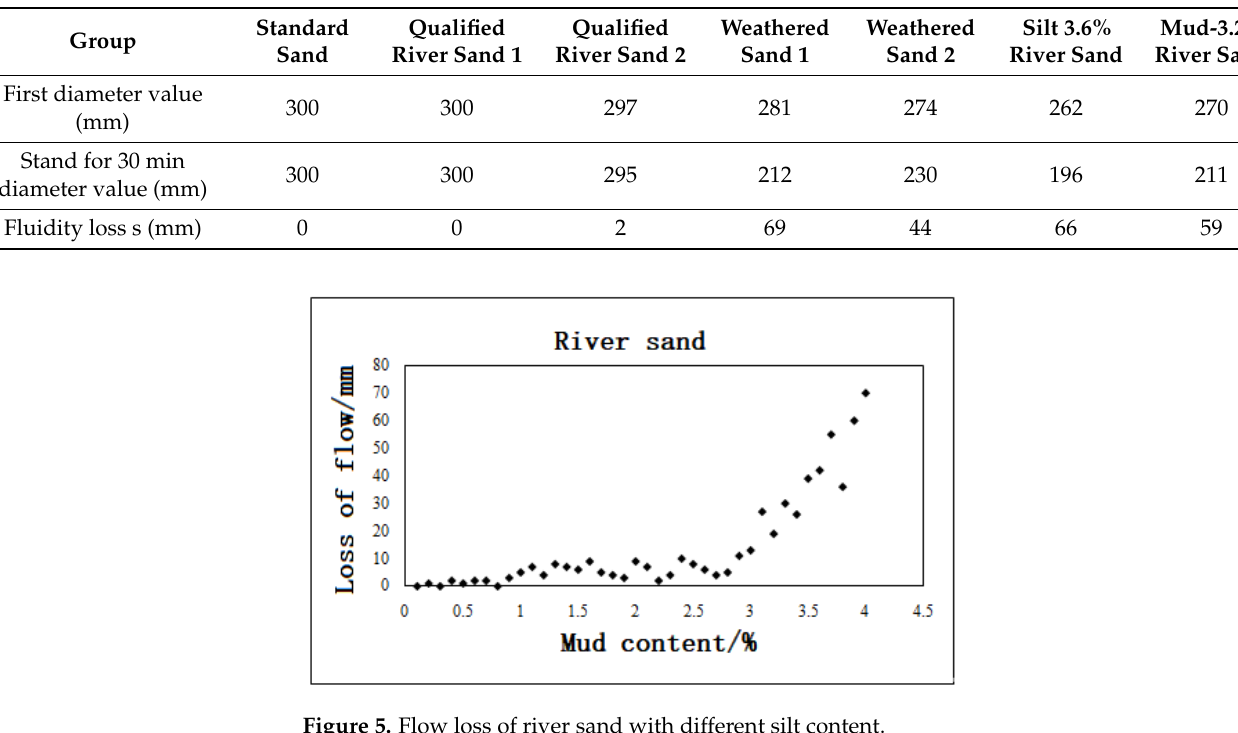
Figure 6. Flowability loss of weathered sand with different mud content . According to test data, the results show that: (1) The loss value of fluidity of river sand with unqualified silt content is large. In com- bination with Figure 5, the relationship between the loss of fluidity of river sand and silt content, the loss value of fluidity of river sand with silt content of more than 3% changes greatly. When the silt content is less than 3%, the loss of fluidity of river sand is less than 15 mm. Therefore, it can be seen that the silt content has a great impact on mobility. First, it is necessary to exclude the impact of the silt content on the material fluidity loss test. (2) The fluidity loss value of weathered sand is significantly larger than that of standard sand and qualified river sand. In combination with Figure 6, the relationship between fluidity loss and mud content of weathered sand, if the mud content of mobilized materials meets the standard, and the fluidity loss value is >15 mm, it can be judged as weathered sand, that is, the river sand is unqualified. (3) The fluidity loss of qualified river sand is less than 15 mm, and the fluidity loss of weathered sand or unqualified sand is more than 15 mm, so the threshold range of qualified material fluidity loss is determined: under the condition of qualified mud content when the fluidity loss is more than 15 mm, it can be judged as weathered sand or mixed sand. The smaller the fluidity loss, the better the river sand quality. 5. Quality Inspection Test of Newly Arrived Sand and Gravel Then, the quality of unknown sand and gravel is detected through two embodiments of mud content and a fluidity test. 5.1. Implementation Ⅰ (1) Mud content test